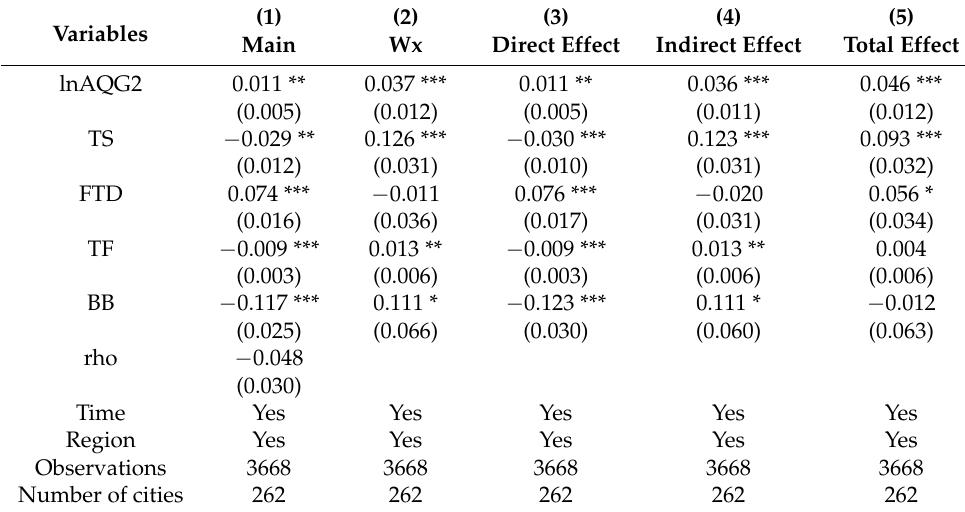
Table 12. Replacement of core explanatory variables.